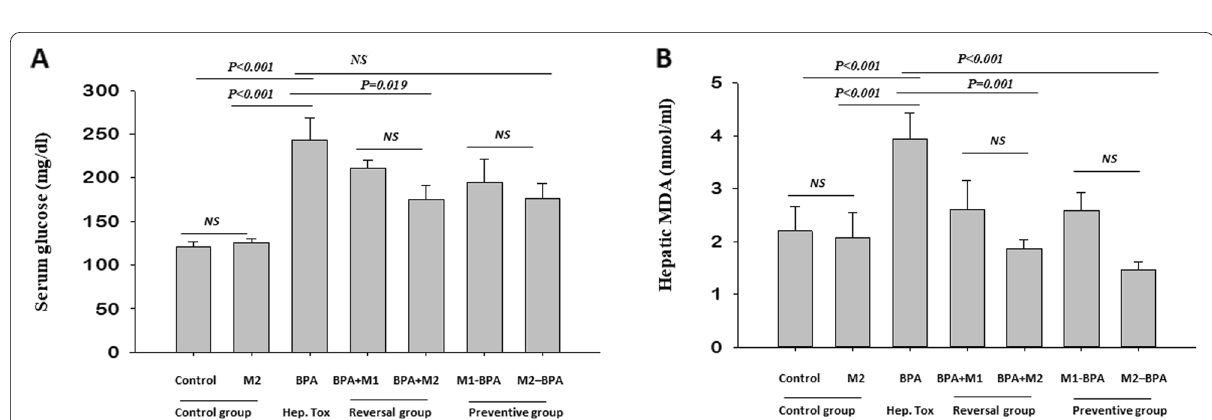
Fig. 2 Effect of Moringa oleifera on serum glucose level and lipid oxidant malondialdehyde in BPA‑induced hepatotoxicity rats. Serum glucose ( A ) and hepatic malondialdehyde (MDA, B ) levels were assessed in all groups. All data were presented as mean bisphenol‑A (50 mg/kg BW). M1 Moringa oleifera (200 mg/kg BW); M2 Moringa oleifera (400 mg/kg BW); P < 0.05 was considered significant. NS non‑significant, P >